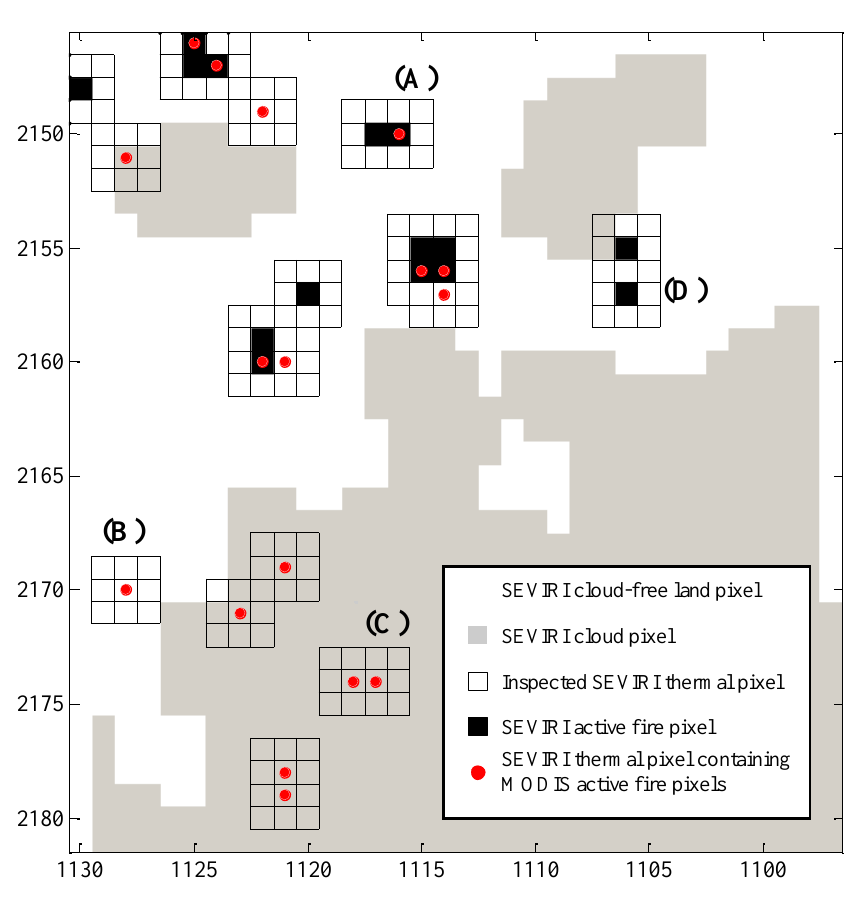
Figure 5. Illustration of the technique used to compare simultaneous SEVIRI and MODIS observations of the same fire activity within ROI 2 (Figure 1a) on 18 November 2008 at 09:30 UTC (shown in the native SEVIRI image coordinate system). For each SEVIRI image coordinate that contains a SEVIRI or a MODIS active fire pixel, a 3 × 3 window is centred on the target pixel and the adjacent SEVIRI pixels are inspected to evaluate SEVIRI’s detection performance. In addition, the status flags of the SEVIRI pixels within the 3 × 3 window are retrieved from the FRP-PIXEL quality file and are used to explain SEVIRI’s active fire errors of omission. Label ( A ) represents a confirmed SEVIRI active fire pixel ( i.e. , no omission or commission error). Label ( B ) highlights a SEVIRI error of omission surrounded only by cloud-free land pixels that are not potential fire pixels. Label ( C ) also indicates a SEVIRI error of omission, but here the error is attributed to the presence of cloud pixels. Label ( D ) is an example of two SEVIRI errors of